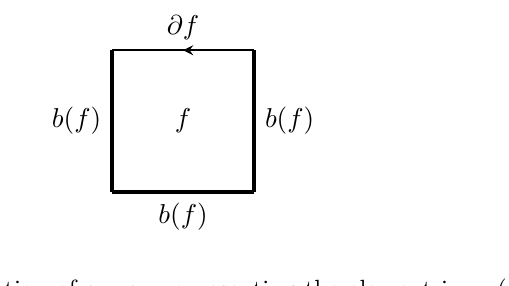
Figure 7 . Schematic representation of a map representing the element in π 2 ( X 2 , X 1 ; b ( f )) corre- sponding to a plaquette f